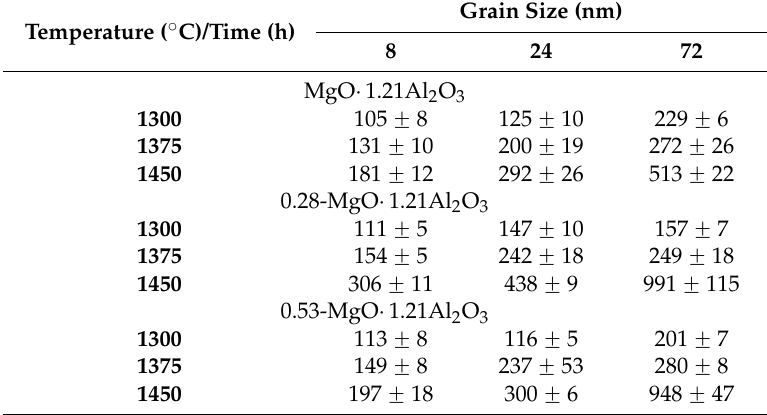
Table 2. Grain sizes of heat-treated, undoped and 0.28 and 0.53 at. % Li-doped MgO·1.21Al 2 O 3 samples. Temperature (°C)/Time (h)